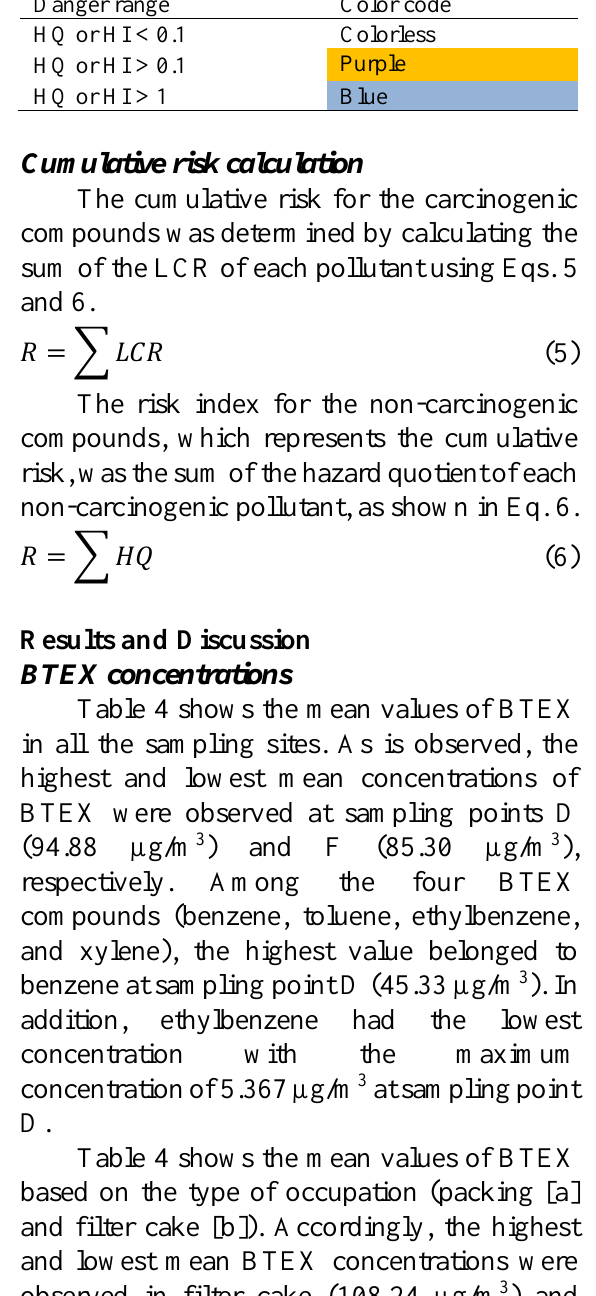
Table 3. RfC range and color codes for each range Hazard Index or